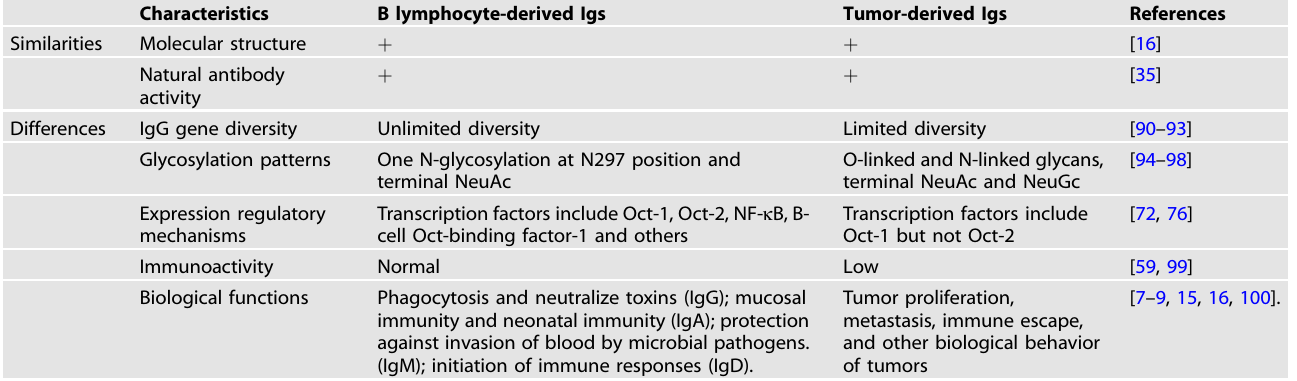
Table 3. The similarities and differences between tumor-derived Igs and B-cell-derived Igs.